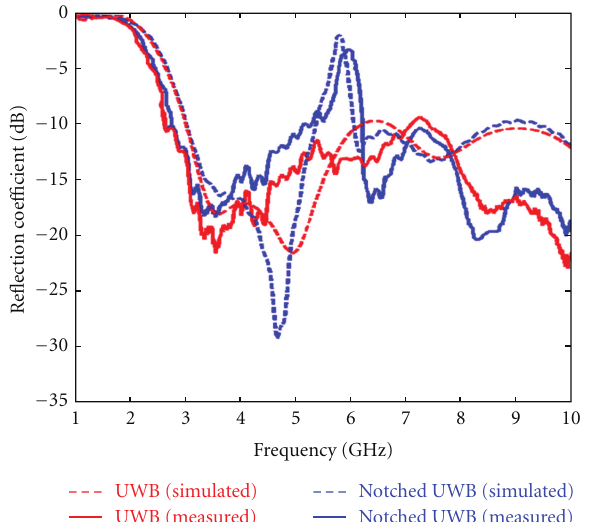
Figure 3: Simulated (dashed lines) and measured (solid lines) reflection coe ffi cient curves when antenna is in UWB mode and in the notched UWB mode.